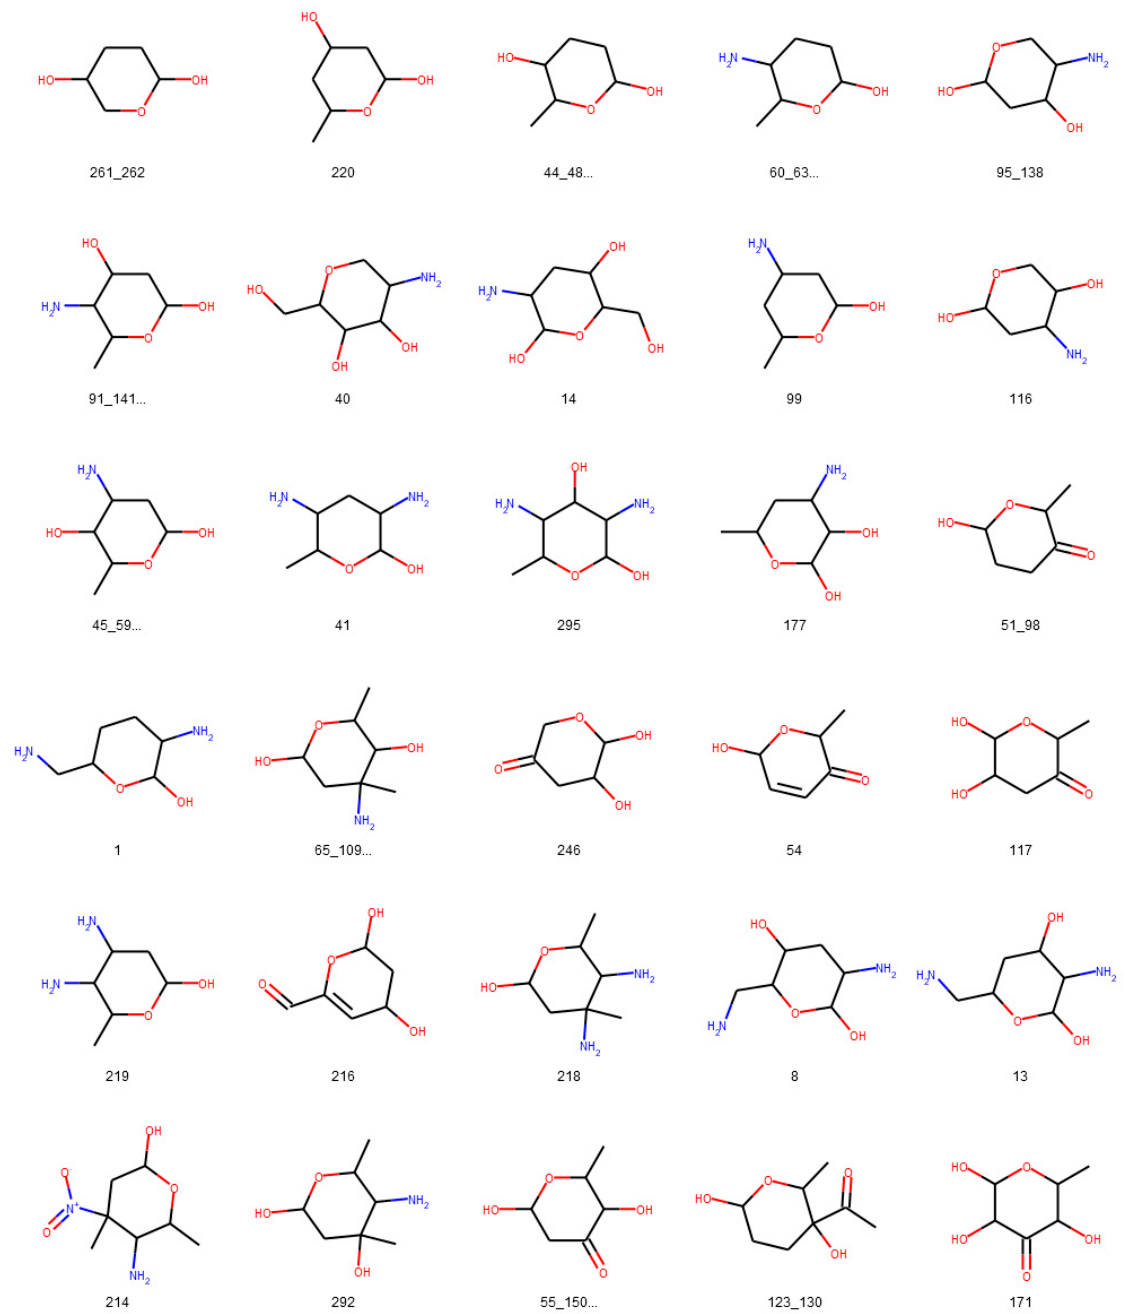
Figure 14. Glycosidic moieties reported in bacterial NPs detected at least ten times in COCONUT, not detectable with the default SRU settings. All moieties are arranged for decreasing frequency in COCONUT, corresponding to the orange bars in Figure 12. The ID below the structures refers to the identifiers used in the original publication of the dataset, concatenated where stereoisomers were grouped.